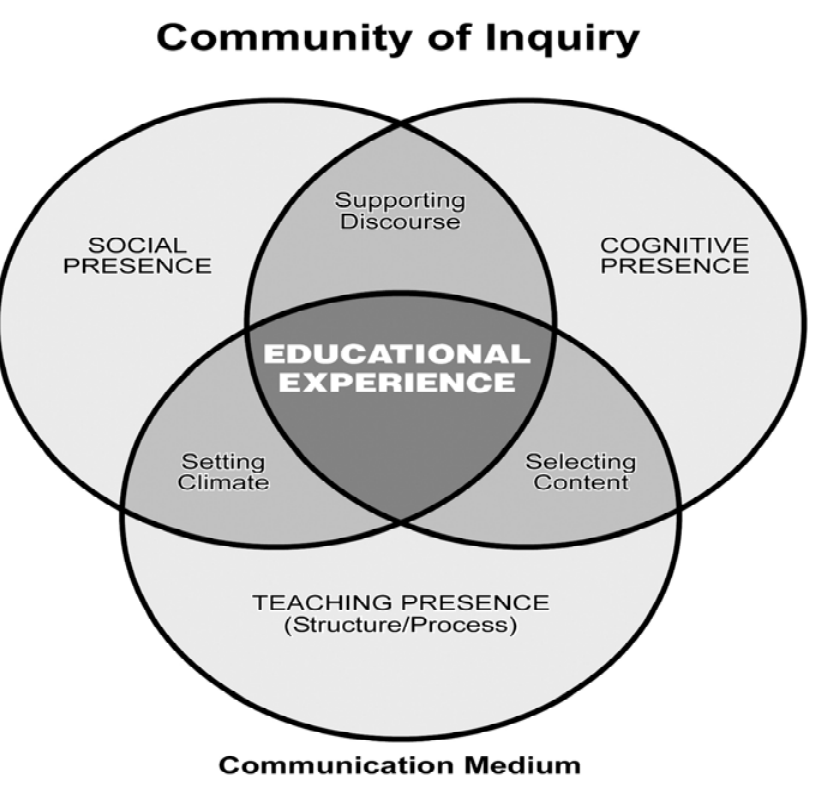
Figure 1 . Community of inquiry